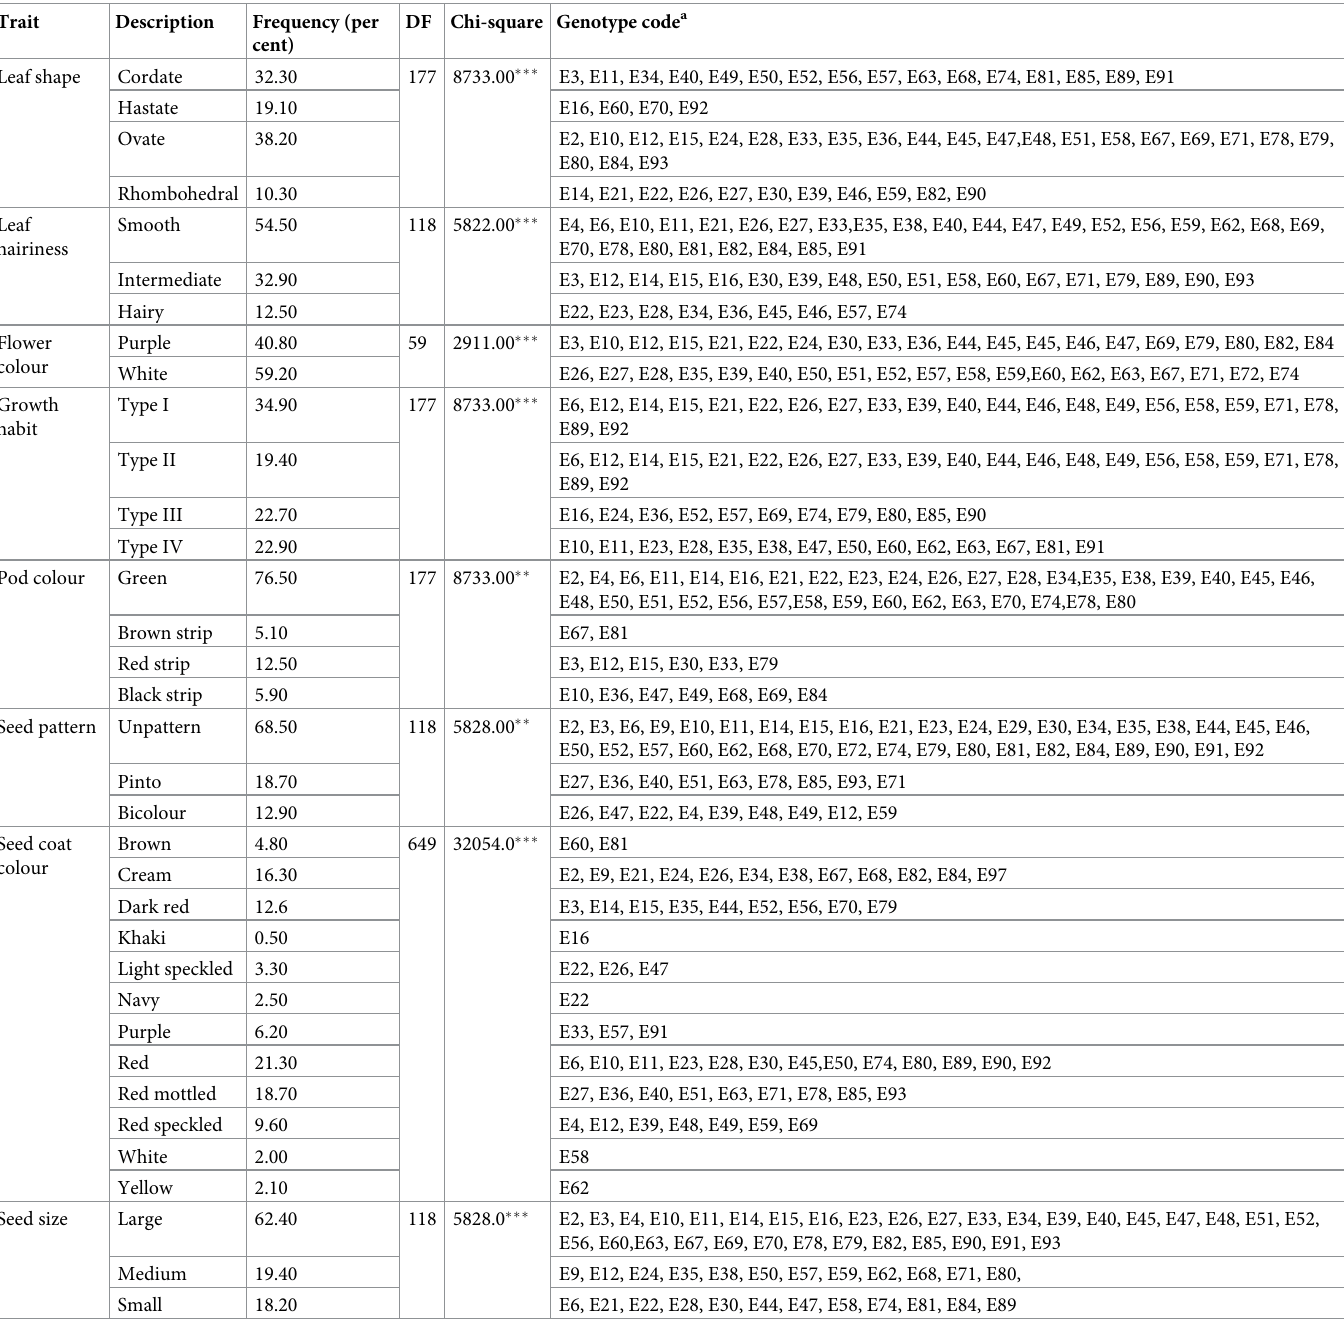
Table 3. Frequency distribution and signficance tests comparing 60 common bean genotype based on qualitative traits.